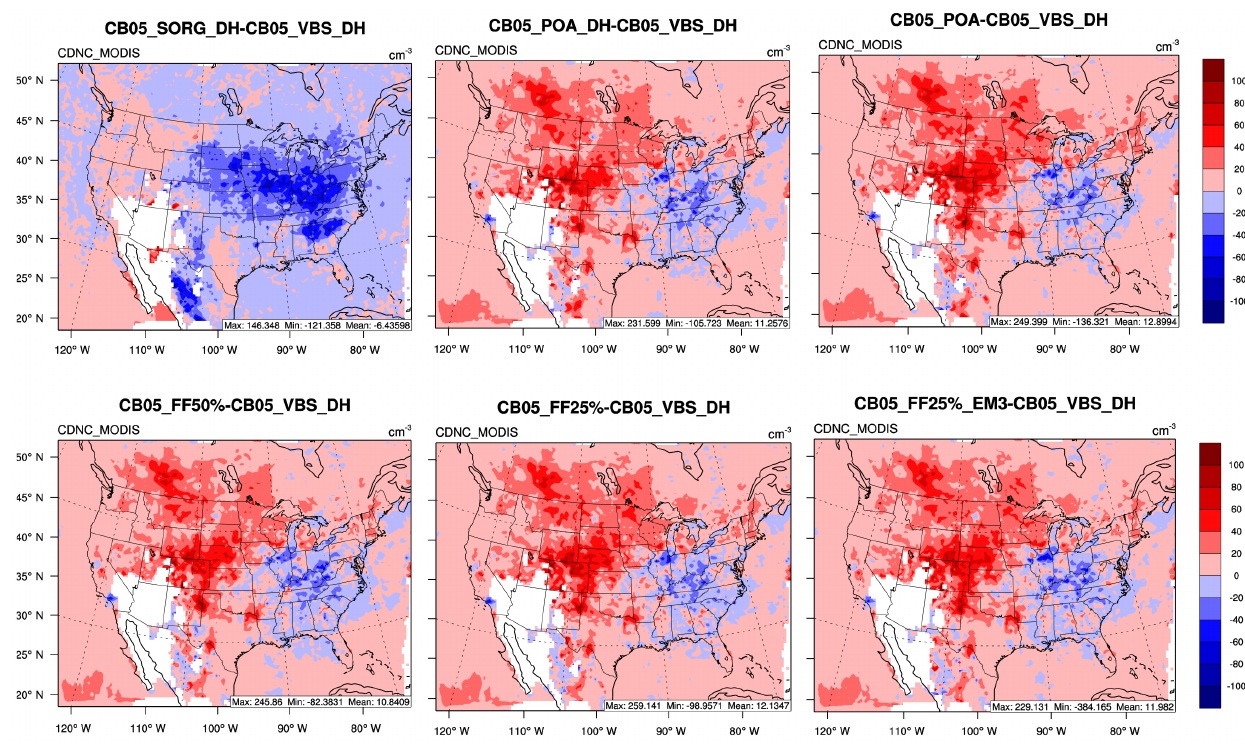
Figure 9. Impact of different VBS cases on CDNC in warm clouds. The plots show the differences between the different sensitivity simula- tions and